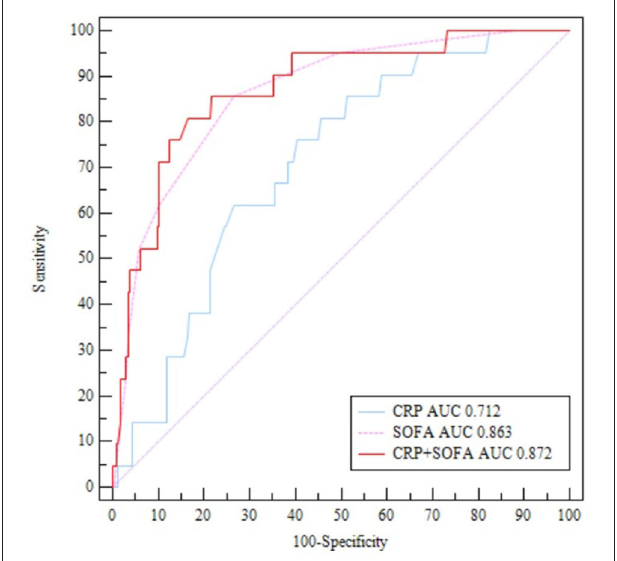
FIGURE 2 | ROC curves for SOFA and CRP in predicting in-hospital